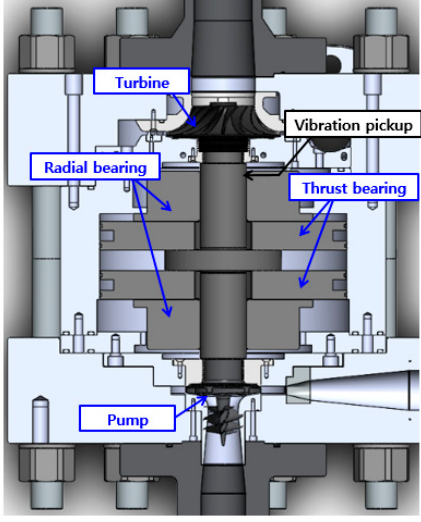
Figure 1. Pump-drive turbine module.